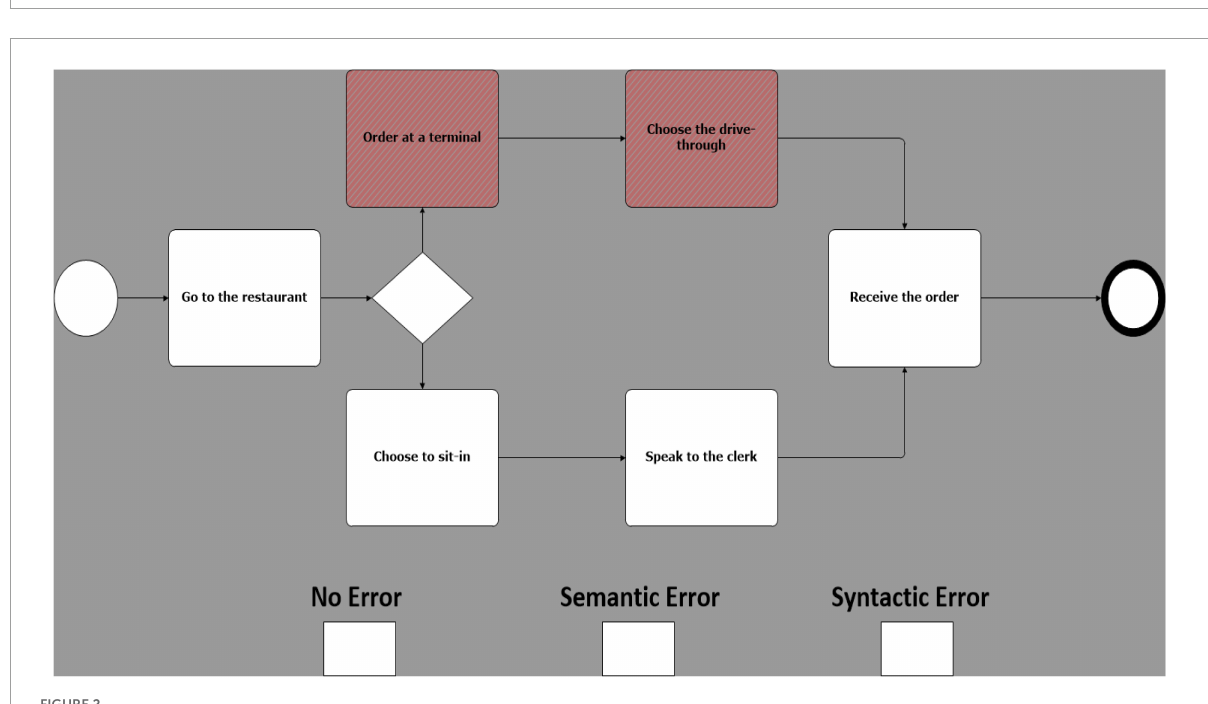
FIGURE2 Example of a model with a semantic error (mis-ordered activities).